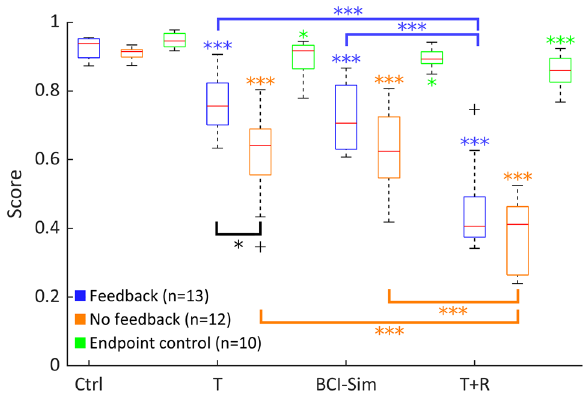
Figure 6. The mean score participants achieved across shapes in the different conditions: Control (Ctrl), Translation (T), BCI-Simulation (BCI-Sim) and Translation plus rotation (T + R). The results are shown for the with-feedback group (blue boxplots), which did the experiment with a physical table matching the virtual tables height, the no-feedback (orange boxplots), which performed the experiment without haptic feedback, and the endpoint group (green boxplots), which did the experiment with a cartesian endpoint control scheme. Stars above boxplots indicate significant differences from the respective group’s control while the blue and purple brackets indicate additional significant differences within their respective group. The black bracket indicates a significant difference between feedback and no-feedback, but within conditions. Note that all conditions (except control) of the endpoint group are significantly different to their counterparts in the feedback-group (not shown in